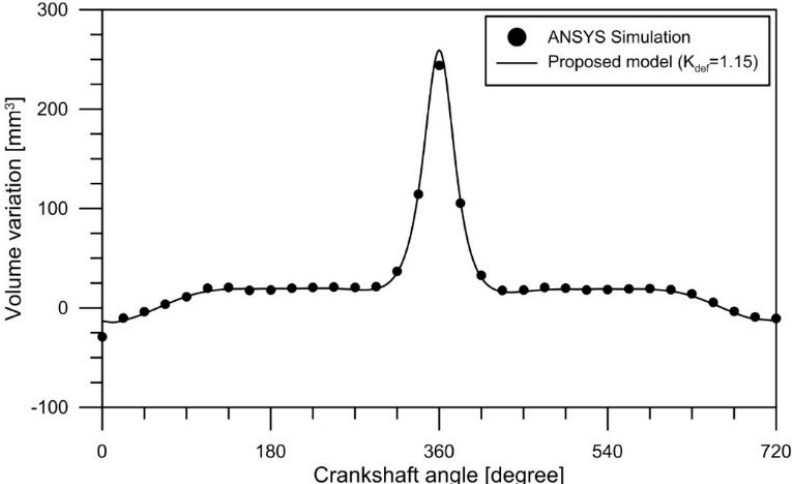
Figure 11. Results of ANSYS ® and the adjusted model, at 2500 rpm.